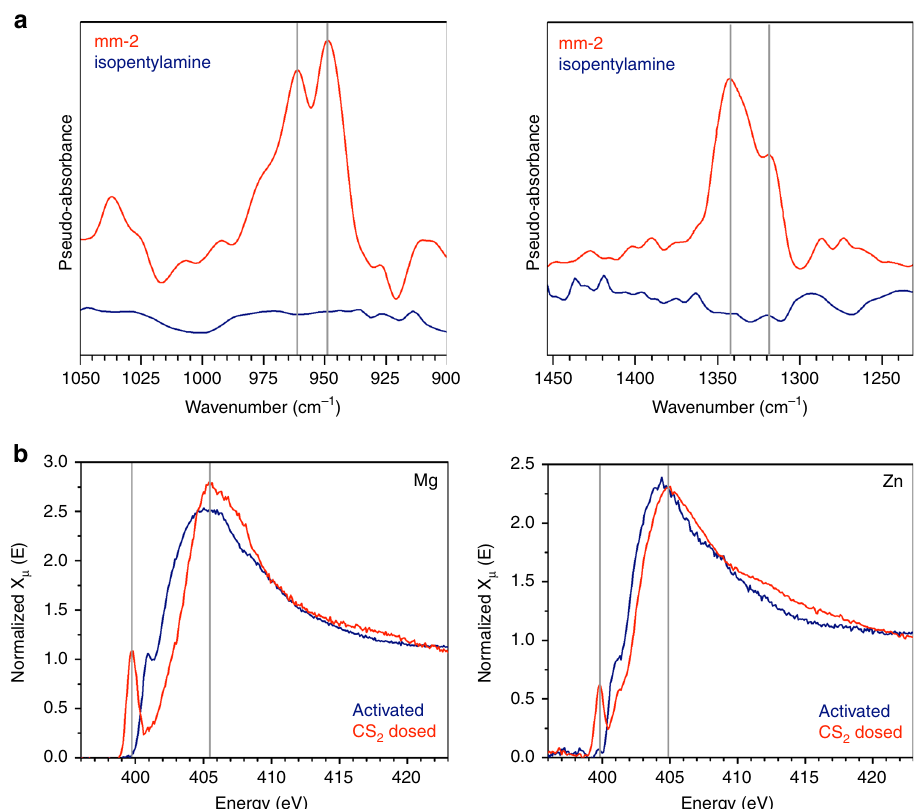
Fig. 5 Spectroscopic characterization of CS 2 Adsorption. a In situ diffuse re fl ectance FT – IR spectra collected upon exposure of activated mm- 2 – Mg 2 (dobpdc) and isopentylamine – Mg 2 (dobpdc) to the vapor pressure of CS 2 at 25 °C. Effects from physisorbed CS 2 on the framework have been subtracted as the baseline to generate difference plots. Two different sets of distinct bands corresponding to new C – S (left) and C – N (right) vibrations are observed for mm-2 – Mg 2 (dobpdc) (red traces), but not isopentylamine – Mg 2 (dobpdc) (blue traces). This observation is in agreement with the presence of two distinct ammonium dithiocarbamate chain conformations. b In situ NEXAFS spectra collected at the N K-edge upon exposure of activated mm- 2 – Mg 2 (dobpdc) (left) and activated mm-2 – Zn 2 (dobpdc) (right) to the vapor pressure of CS 2 at 25 °C. After exposing the activated samples to CS 2 , the environmental cell was evacuated to remove physisorbed CS 2 before the measurement was taken. Both congeners show a new pre-edge feature and a shift of the main edge upon CS 2 exposure, indicative of ammonium dithiocarbamate formation. All major spectral changes have been